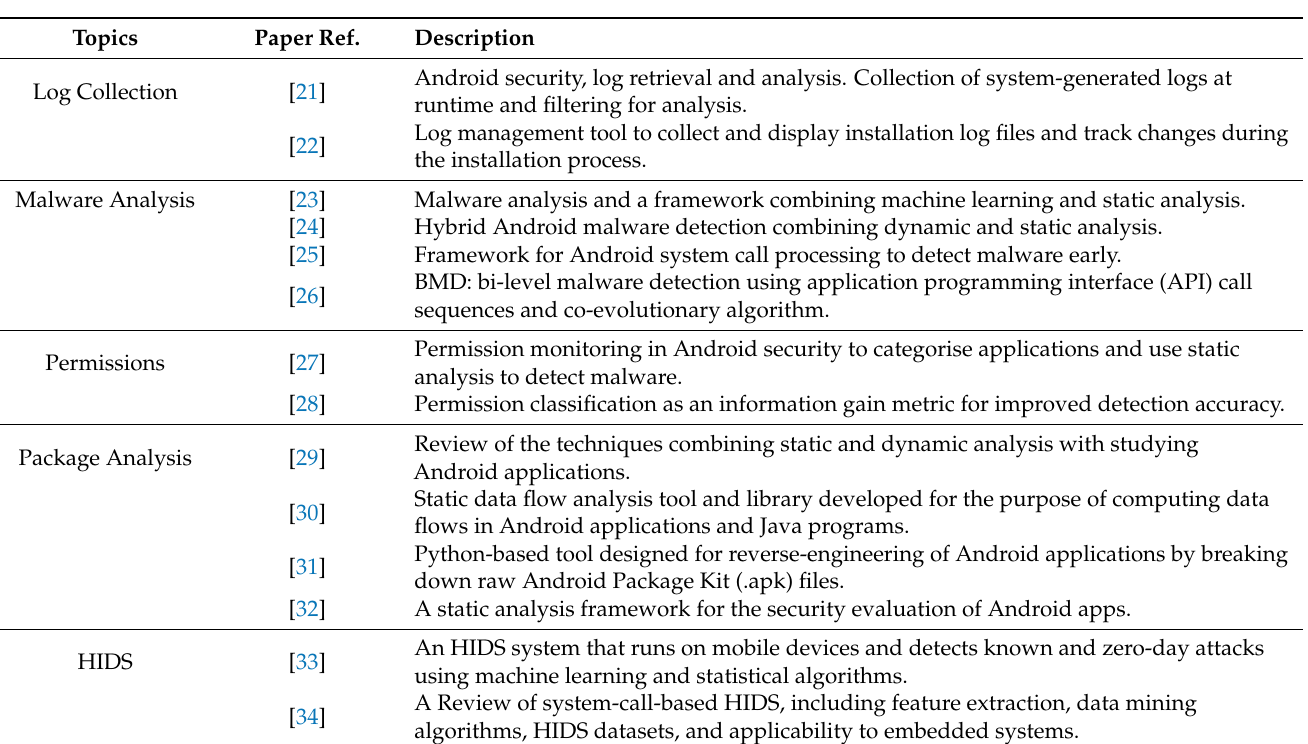
Table 1. Table summarising the related